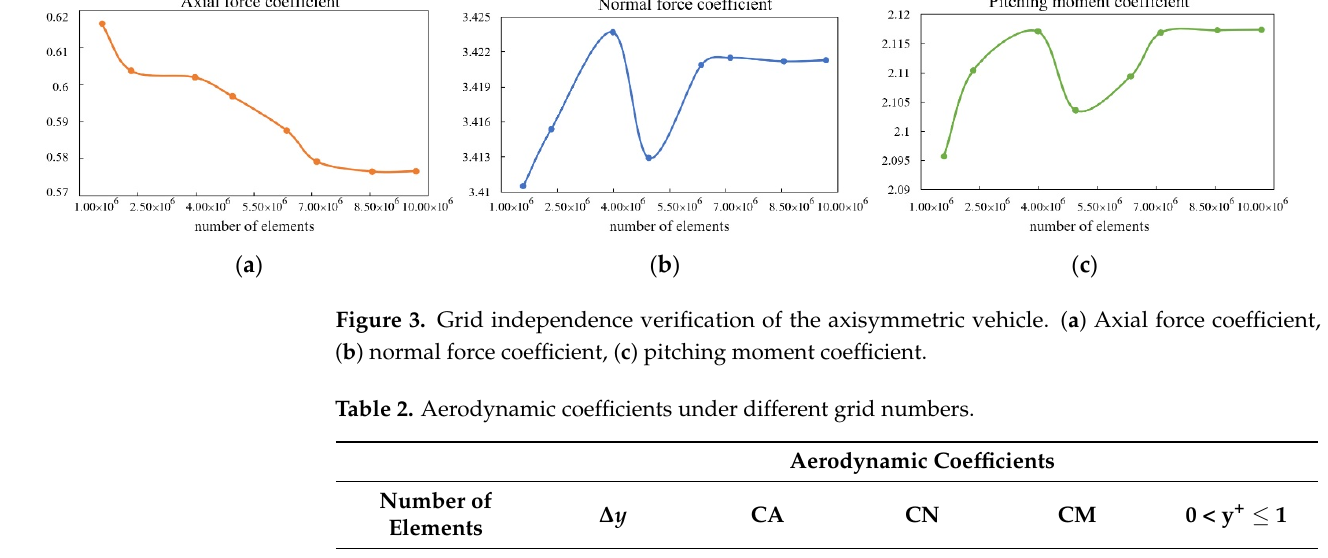
Table 2. Aerodynamic coefficients under different grid numbers.